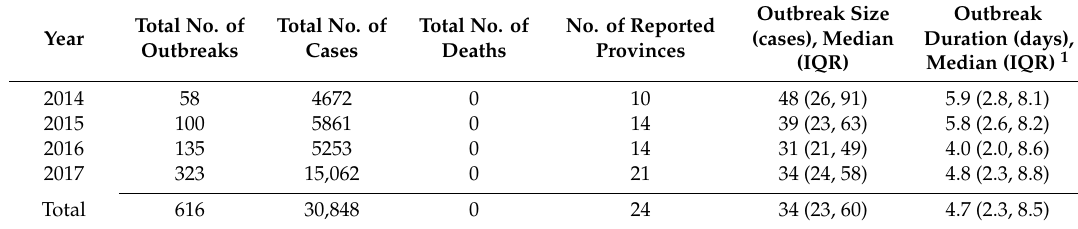
Table 2. Number of reported norovirus outbreaks and outbreak-associated illnesses in China,